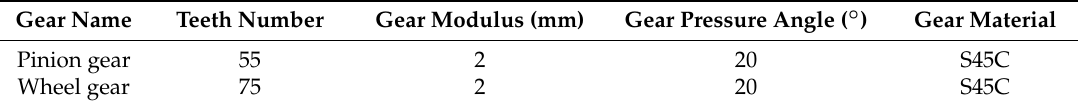
Table 1. Gear parameters of the test gearbox.